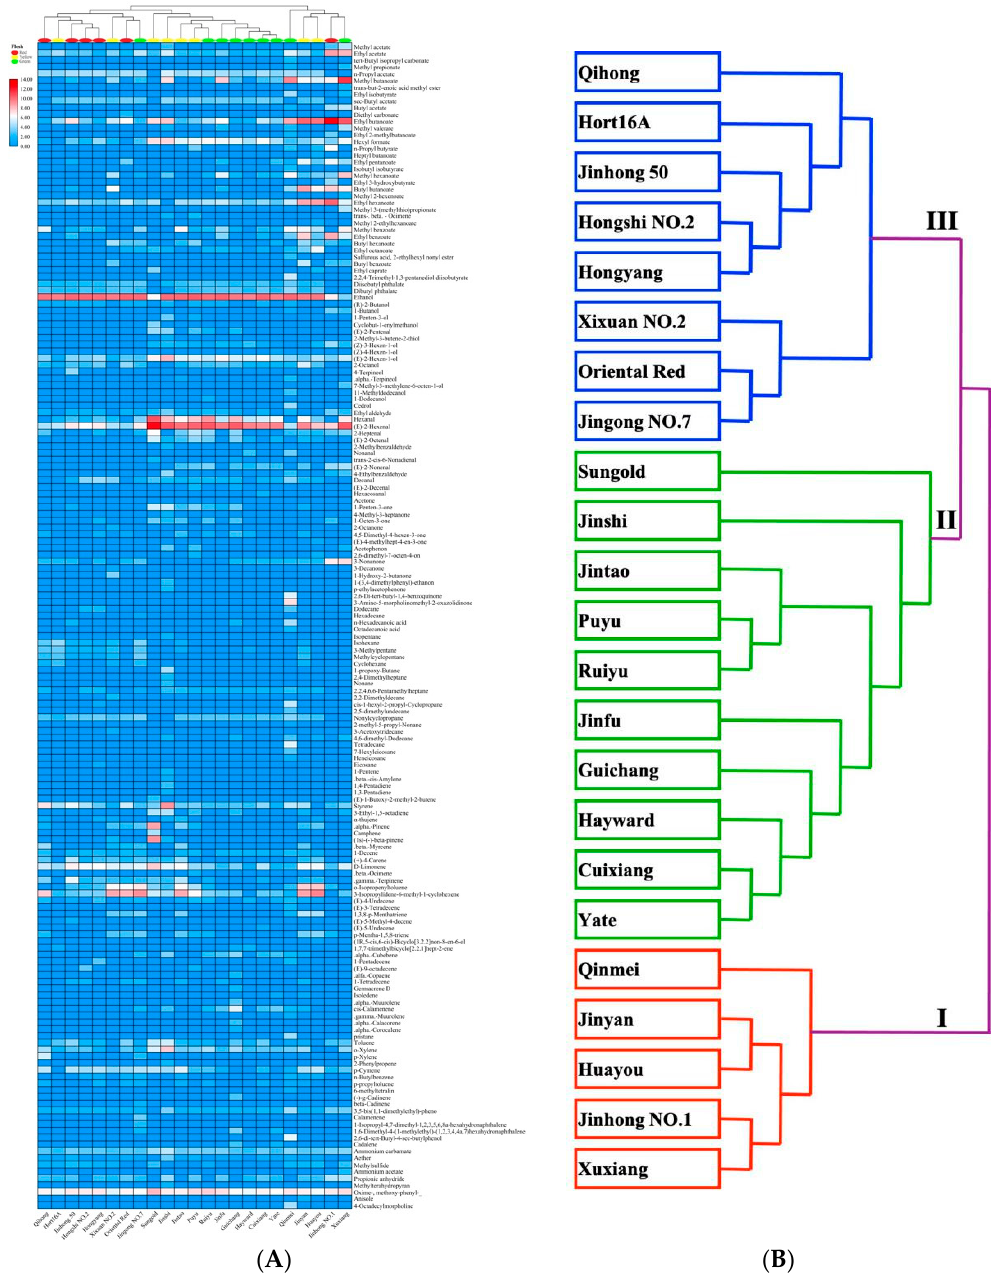
Figure 2. Cluster heat map analysis ( A ) was performed on all volatile components in the kiwifruit samples, and a simplified cluster map ( B ) is presented (I–III: three major categories based on the GC-MS date).